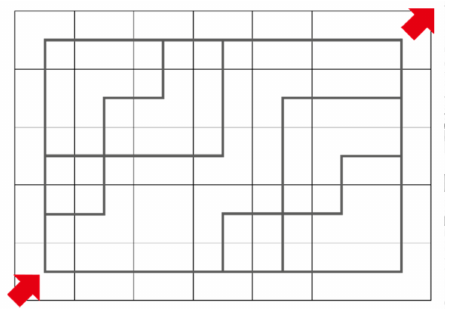
Figure 4. An illustration of the path symmetry. Red arrows represent search direction of two nodes in the grid and bold black lines are different paths between two nodes, often they are symmetrical, because the only difference between them lies in the order of